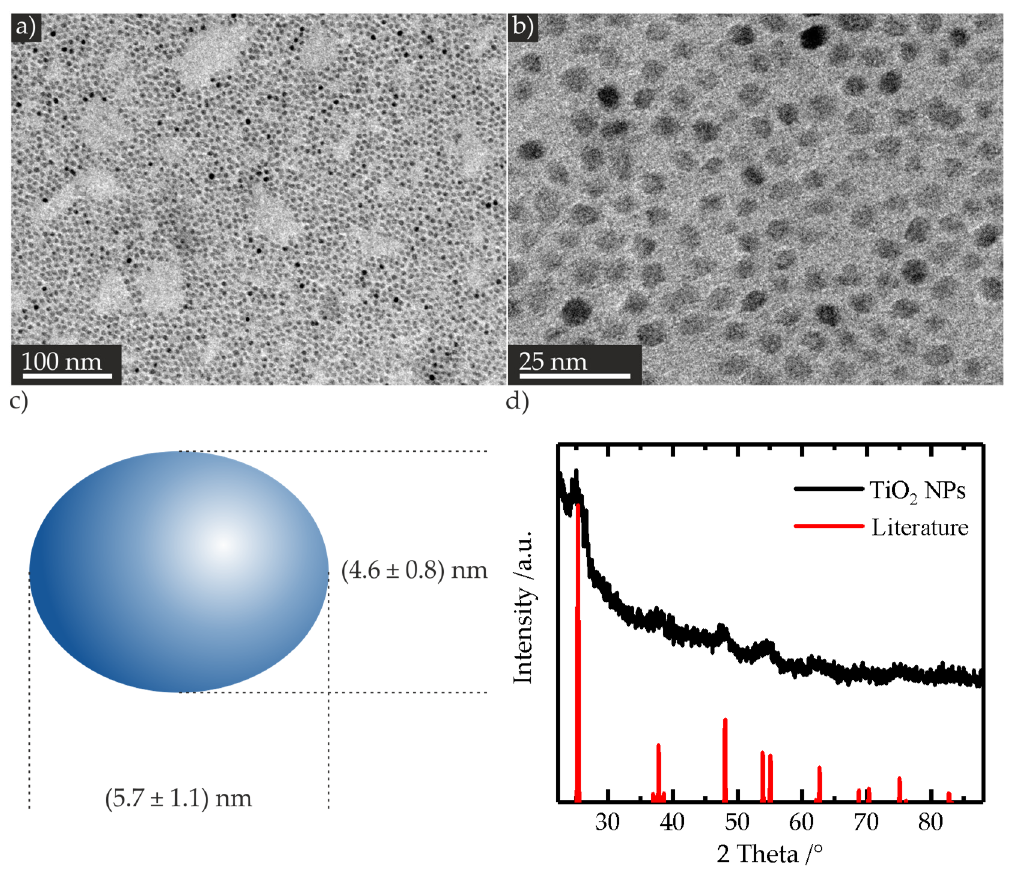
Figure 1. Representative TEM images of the synthesized TiO 2 nanoparticles (NPs) ( a , b ). Schematic illustration of the NP with the corresponding mean longitudinal and transversal ( c ). Powder XRD reflection patterns of the NPs (black), and simulated literature anatase reflection patterns (red) ( d ).